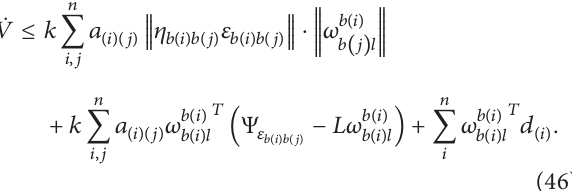
Figure 6: Euler angle response, 𝜙 𝑏𝑑 ; Theorem 5.